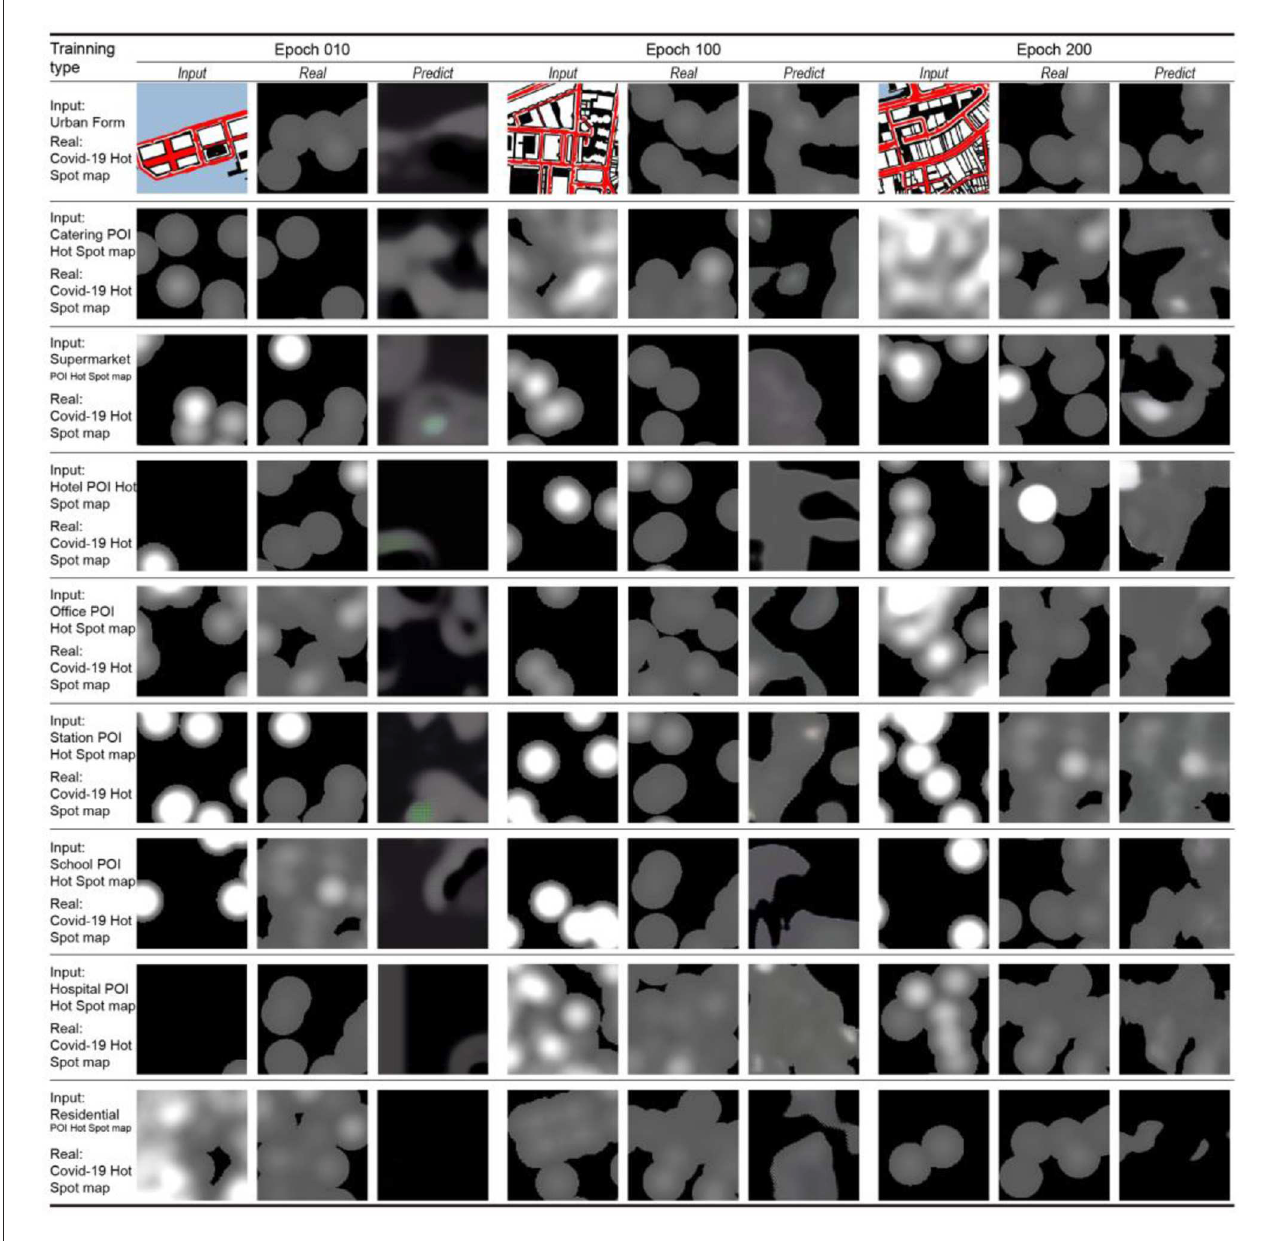
FIGURE7 Diagram of iterative training